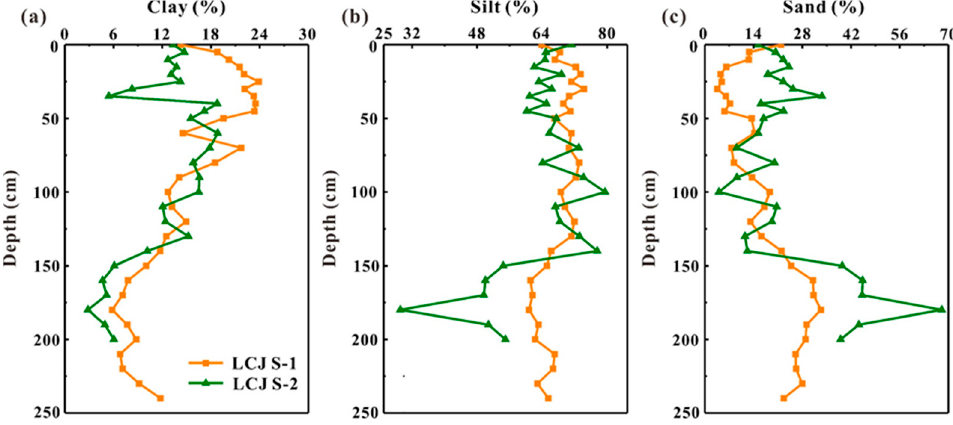
Figure 5. Vertical distributions of clay ( a ), silt ( b ) and sand ( c ) percentages in soil profiles.